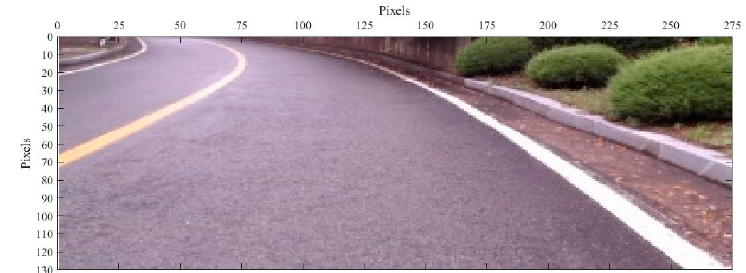
Figure 18. Front-view camera image in pixel coordinate system.